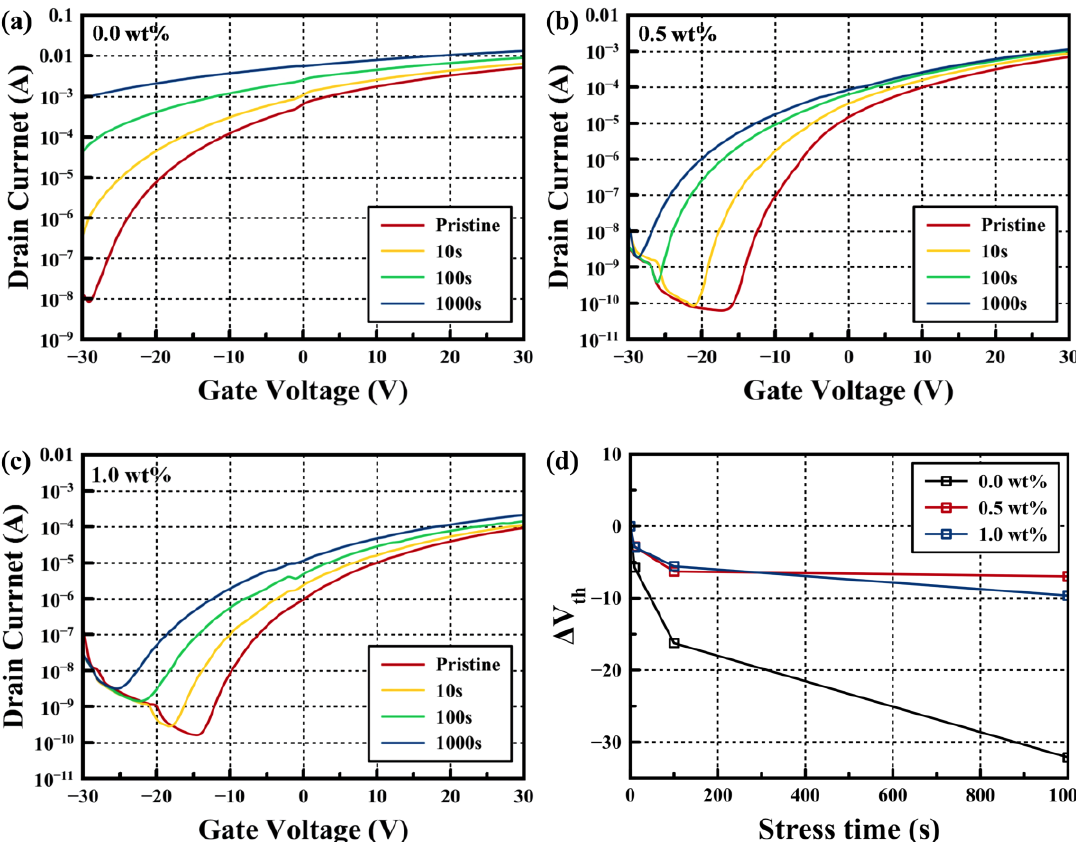
Figure 6. Transfer curves of solution-processed SnO 2 TFTs depending on Mg doping concentration ( a ) 0.0 wt% ( b ) 0.5 wt% ( c ) 1 wt% and ( d ) The V th shift under a negative bias stress.